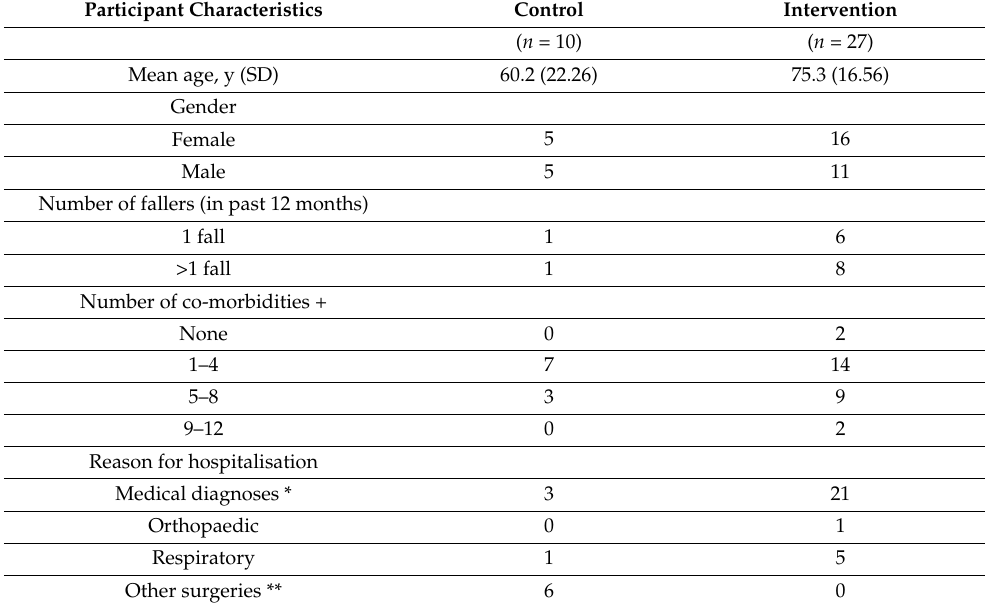
Table 1. Patient participant characteristics.